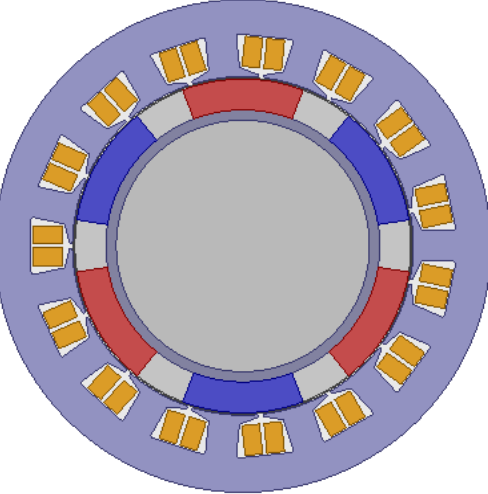
Figure 5. Two-dimensional models of the motor.